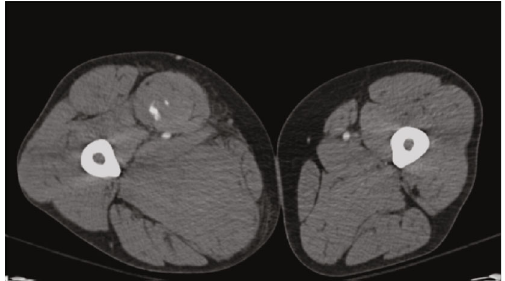
Figure 1: An axial CTA image of bilateral thighs demonstrating a hematoma in the sartorius of the right thigh.